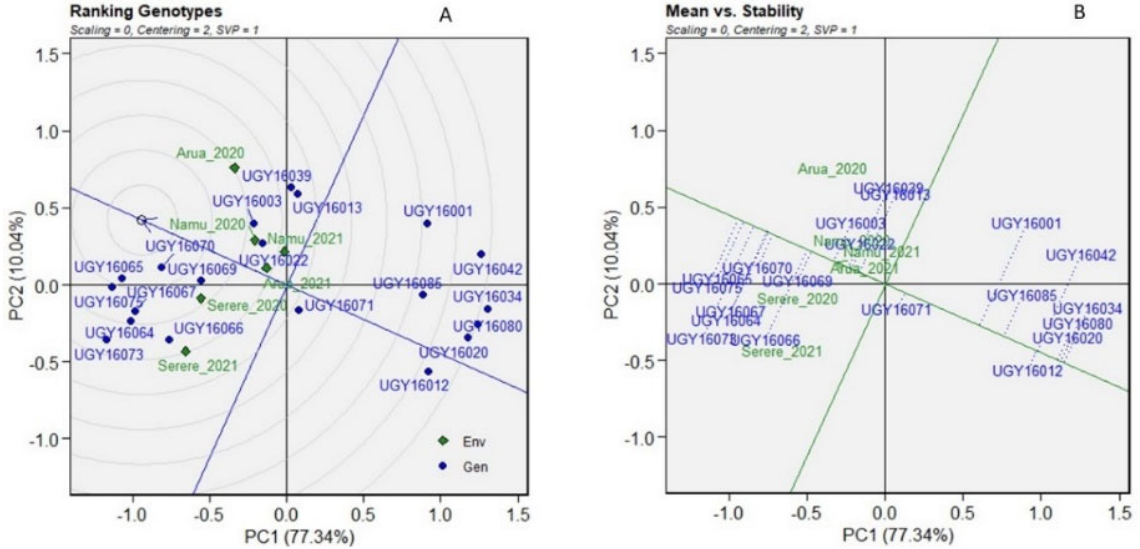
Figure 4. GGE ranking biplot showing ( A ) mean performance and ( B ) stability of 20 yam genotypes for yam mosaic virus, evaluated in six environments.